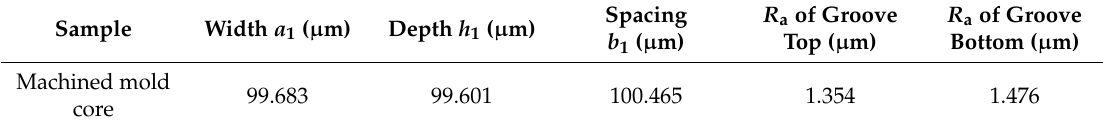
Figure 6. 3D topographies and section profile curves of micro-structured mold core surface. 196 Table 2. The surface roughness and groove size parameters of the machined micro-structured mold 197 core. 198